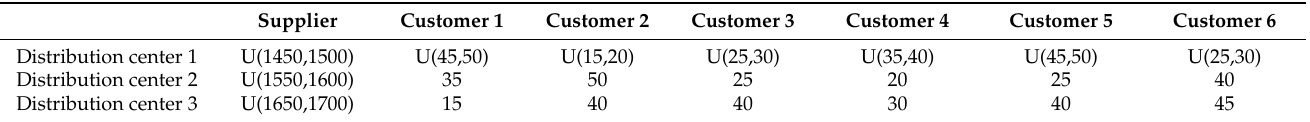
Table A4. Transportation time between two echelons of facilities.